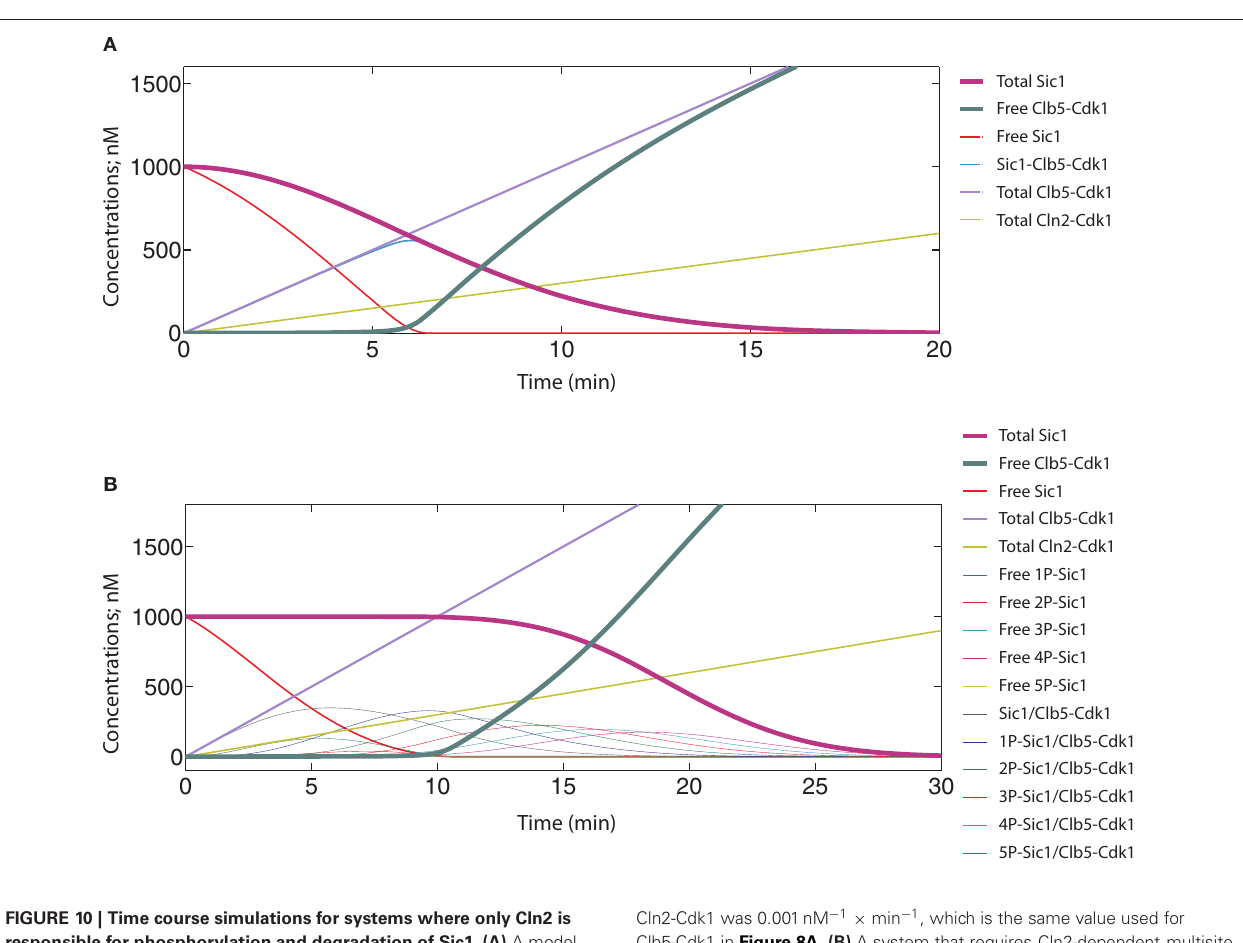
FIGURE 10 | Time course simulations for systems where only Cln2 is responsible for phosphorylation and degradation of Sic1. (A) A model similar to that in Figures 8 and 9 was used, except that the rate constant value for Clb5-Cdk1 toward Sic1 was taken to be zero. The rate constant for